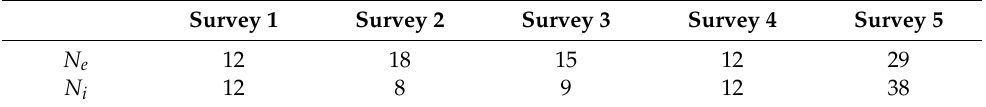
Table 1. The number of extroverted and introverted participants in each of the five surveys conducted. Survey